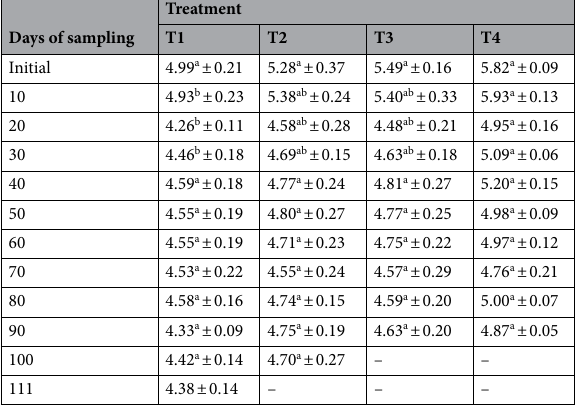
Table 7. Chicken litter biochar on soil pH in water at one hundred and eleven days after transplanting of MR219. Different letters within a row indicates significant difference between means of four replicates ± standard error using Tukey’s test at p ≤ 0.05.